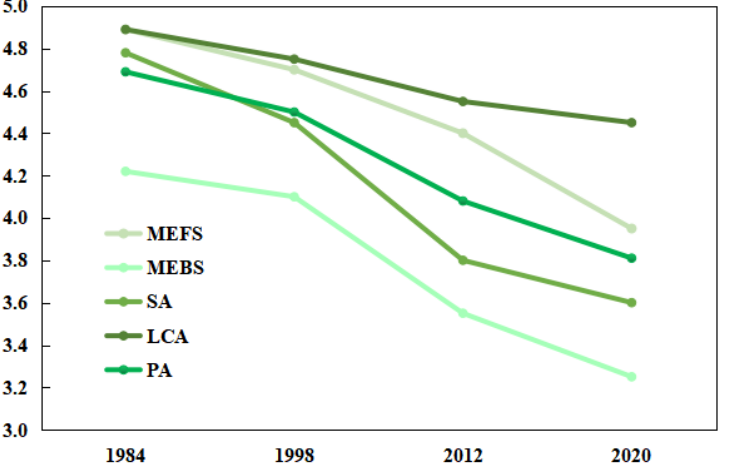
Figure 7. Intensity index of the place attachment of local farmers. MEFS = The sense of familiarity with the material environment; MEBS = The sense of belonging to the material environment; SA = Social attachment; LCA = Attachment to the local culture; PA = Place attachment.